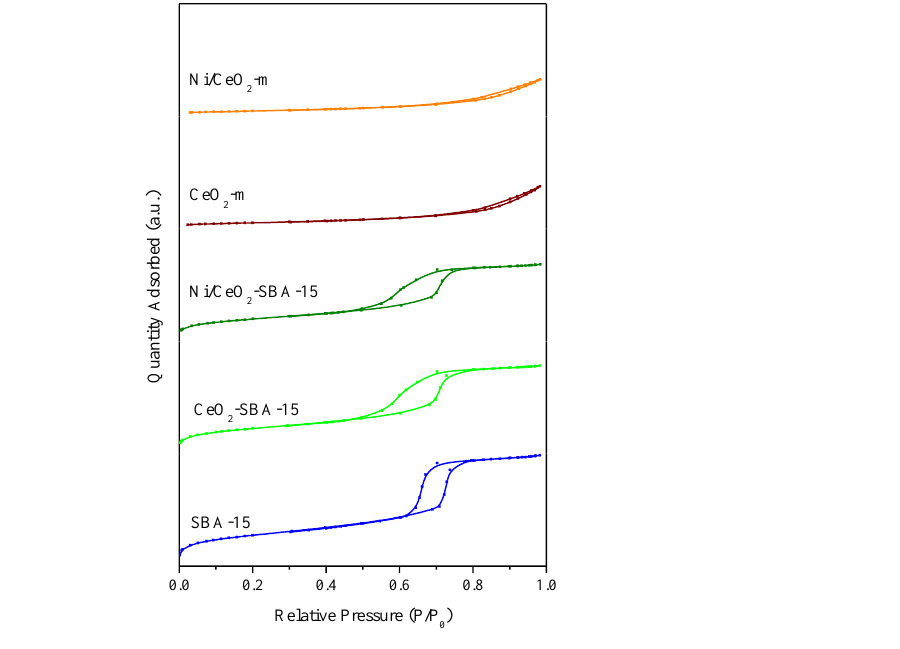
Figure 1. Nitrogen adsorption – desorption isotherms for the prepared Ni-based catalysts.